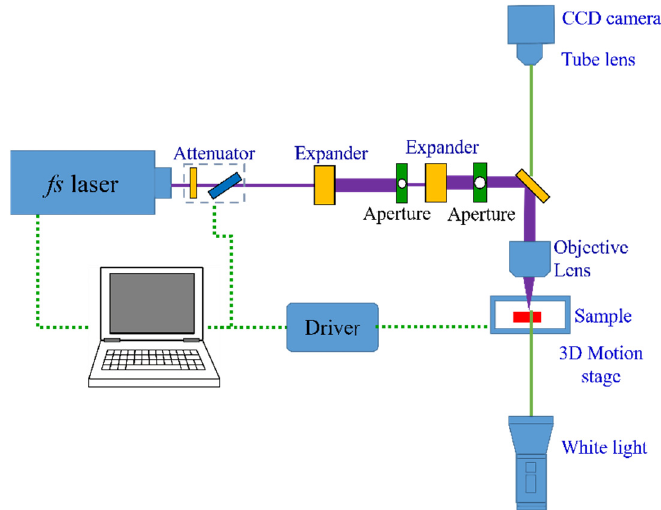
Figure 6. The schematic of femtosecond laser fabrication setup.